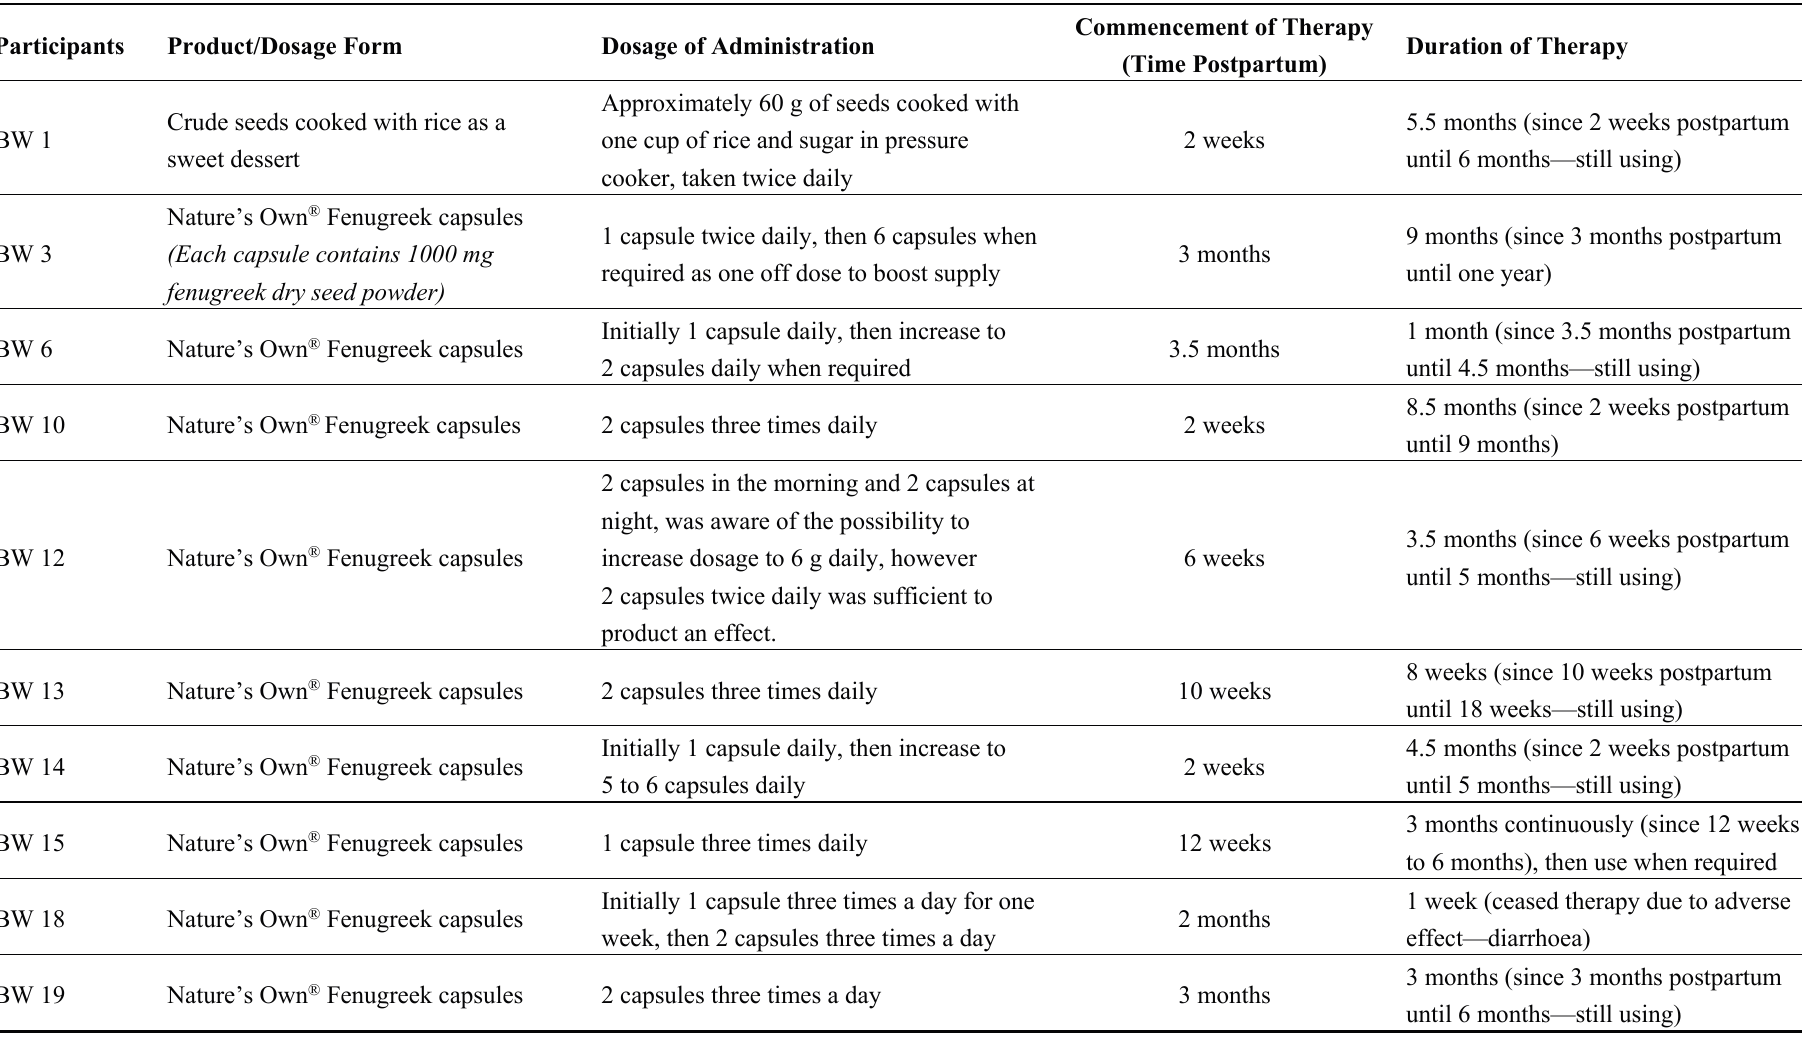
Table 1. Summary of the pattern of use: fenugreek as a sole